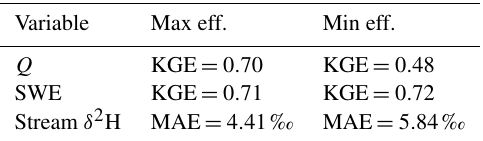
Table 2. Efficiency ranges of 100 best calibrations, selected to si- multaneously have the highest KGE for discharge and SWE and lowest MAE for stream δ 2 H. Variable Max eff. Min eff. Q KGE = 0 . 70 KGE = 0 . 48 SWE KGE = 0 . 71 KGE = 0 . 72 Stream δ 2 H MAE = 4 . 41‰ MAE = 5 .